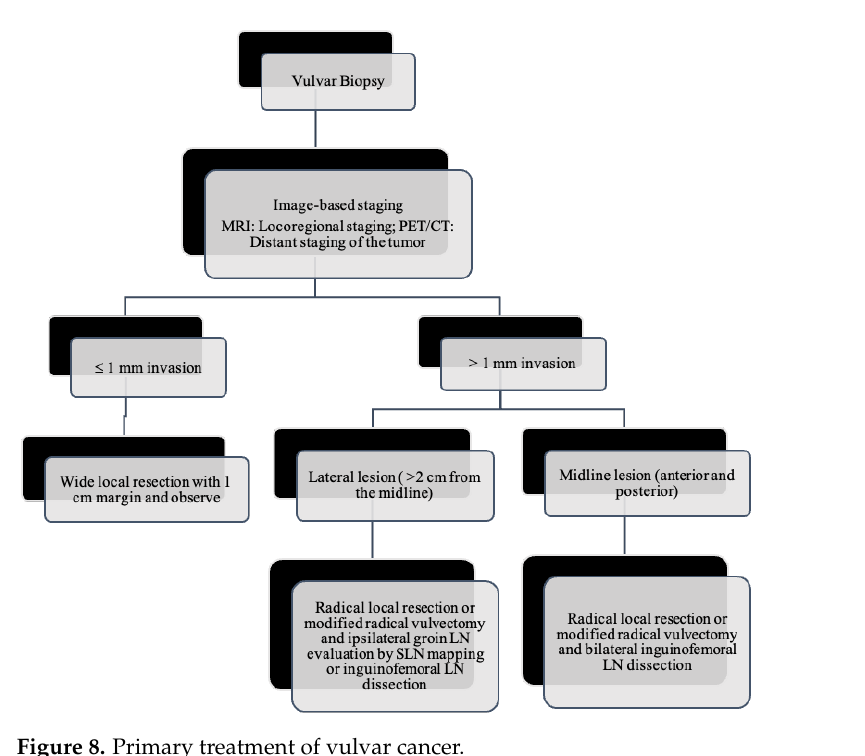
Cancers 2022 , 14 , x FOR PEER REVIEW Figure 8. Primary treatment of vulvar cancer. Figure 8. Primary treatment of vulvar cancer.